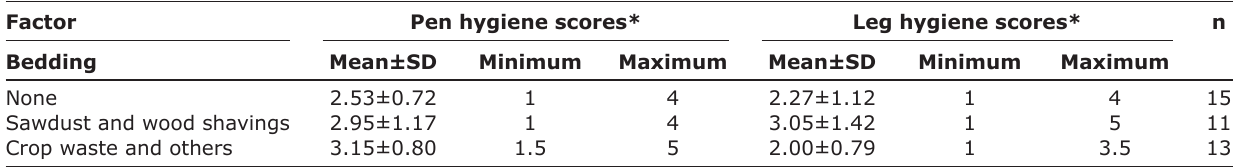
Table-2: Descriptive statistics of pen hygiene and leg hygiene scores across three types of bedding availability for 39 calves on 28 smallholder dairy farms in Meru County, Kenya, 2017. Factor Pen hygiene scores* Leg hygiene scores* Bedding